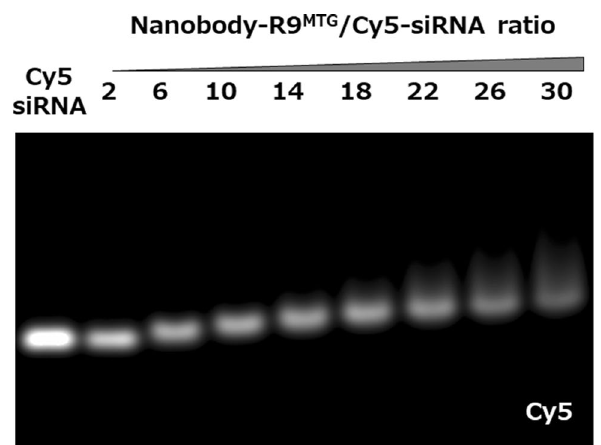
Figure 5. Interaction between siRNA and Nanobody-R9 MTG . Electrophoretic mobility shift assay of Nanobody- R9 MTG and siRNA complex detected by Cy5. Full-length gel image provided in Supplementary Fig.